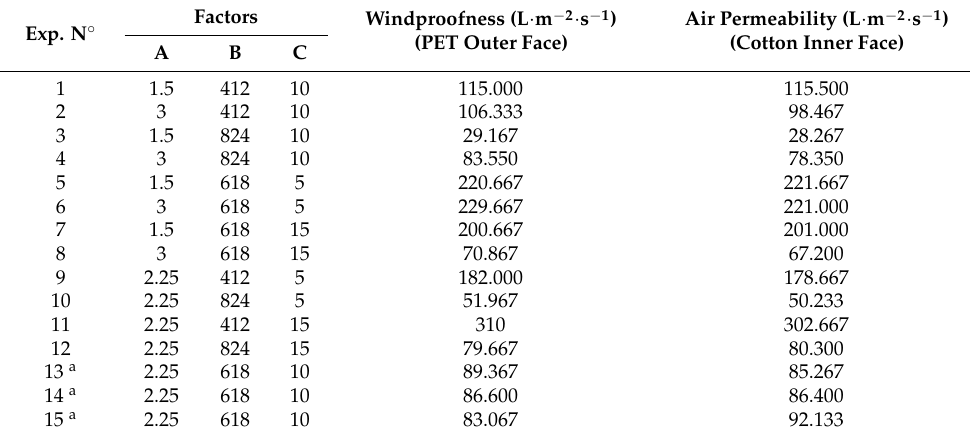
Table 2. Windproofness and air permeability values of the treated samples.